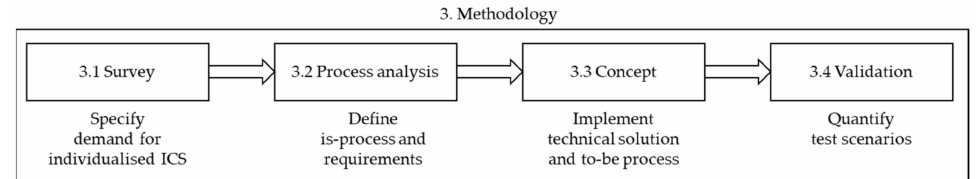
Figure 3. Overview of the methodology presented in Section